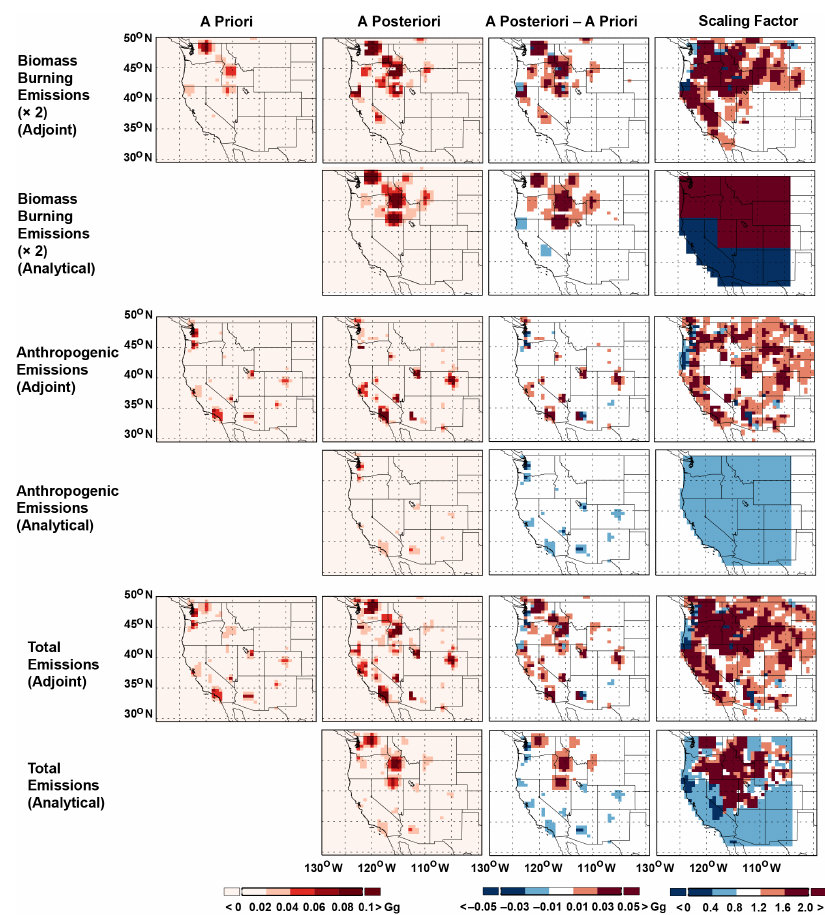
Figure 7. Same as Fig. 2, but at 0.5 ◦ × 0.667 ◦ (Case 9, same as Case 1, except at 0.5 ◦ × 0.667 ◦